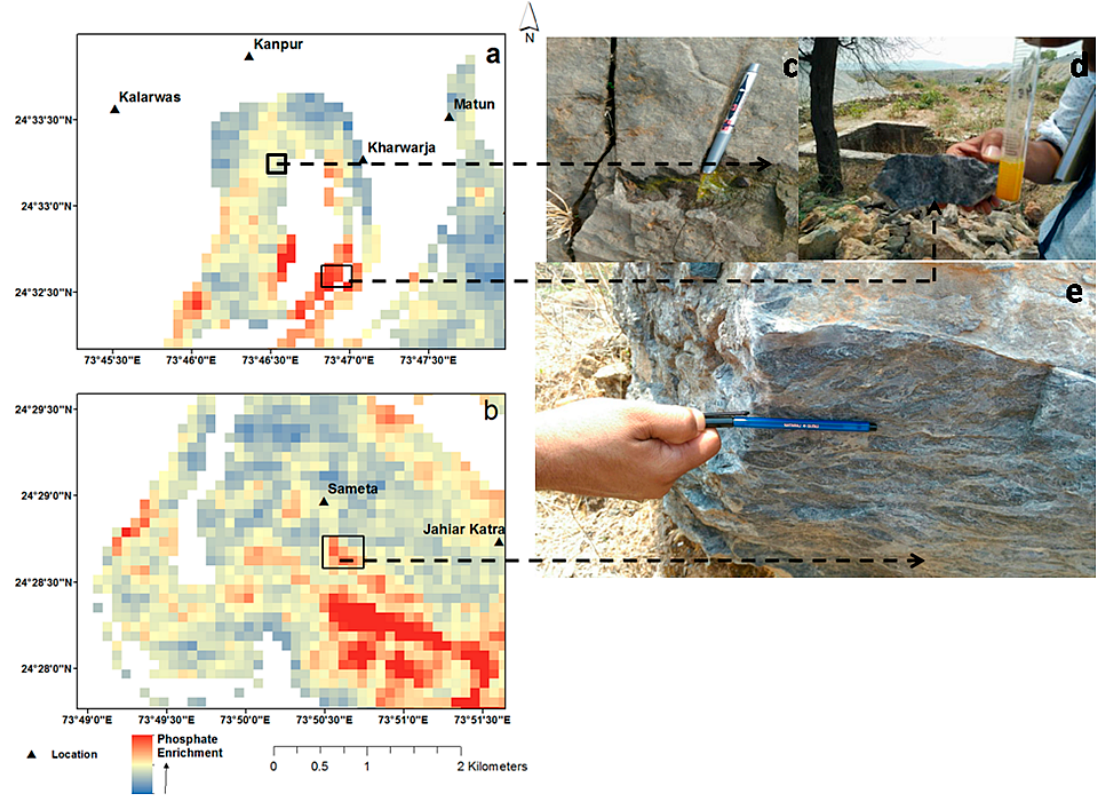
Figure 13. ( a ). Density sliced relative band depth image for Kharawarja (Matun). ( b ). Sameta and the Jhmar Kotra mine. High phosphorite rich zones have been demarcated with red color. Field check areas beyond the present mine are shown with a rectangle. Field validation in the east of the Kharwarja area ( c ) and south of the Kharwarja area ( d ) and Sameta area ( e ).